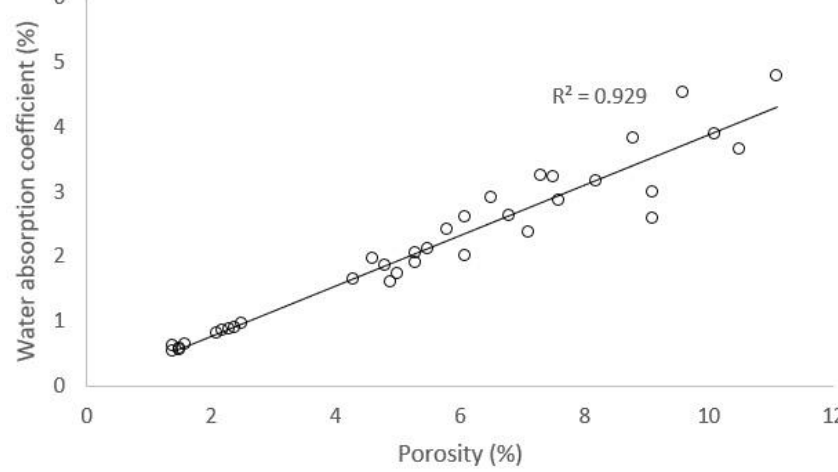
Figure 18. Relationship between effective porosity and water absorption coefficient.